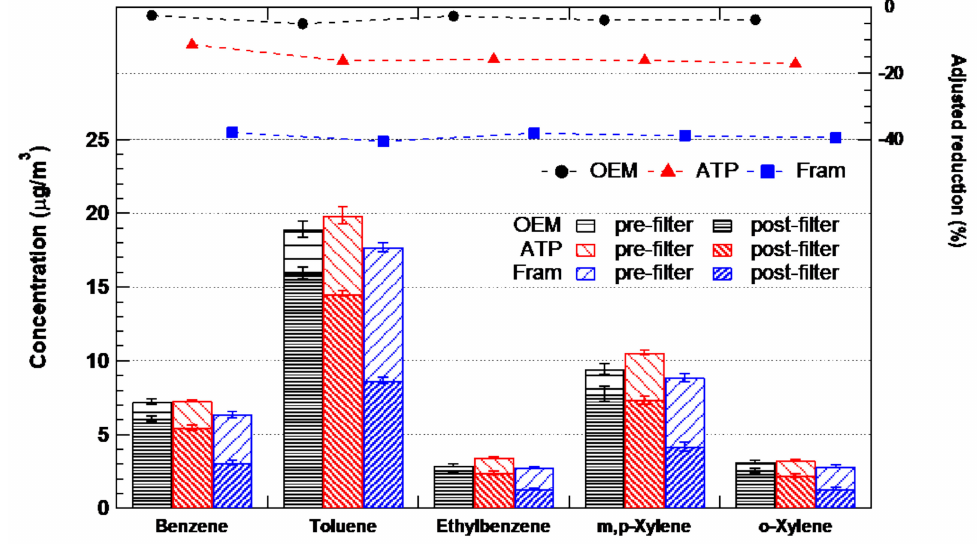
Figure 12. Measured BTEX concentrations at pre- and post-filter locations for various cabin